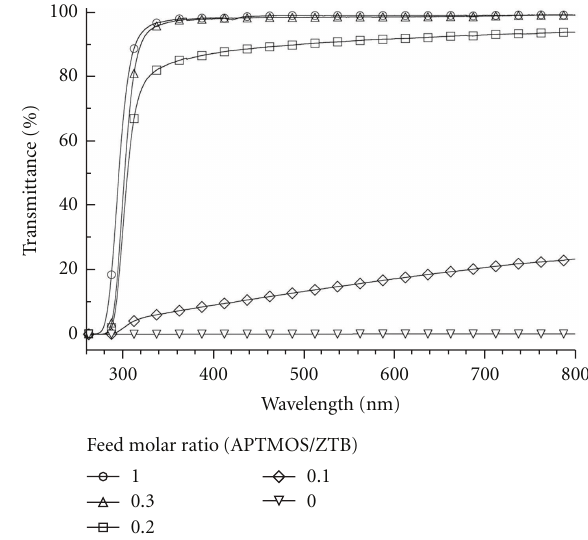
Figure 1: UV-Vis spectra of aqueous dispersions (1.0w/v%) of SQ/ZrO 2 -NPs obtained with various feed molar ratios.